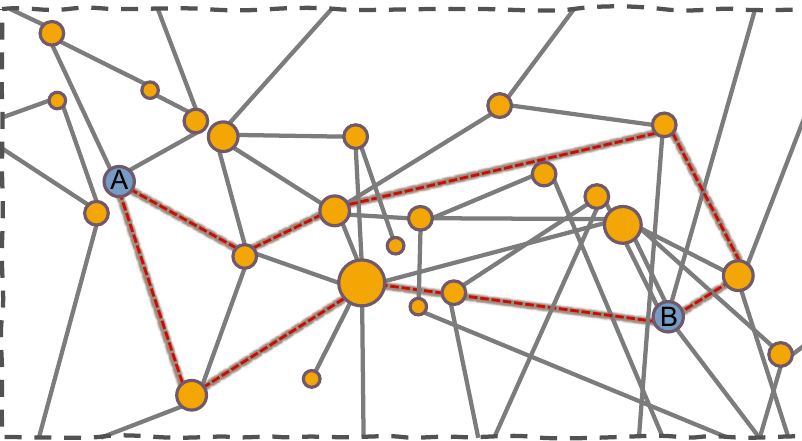
Fig. 1 Quantum communication network. Two arbitrary end-users, Alice (A) and Bob (B), can communicate through diverse, not necessarily direct, routes that extend across intermediate untrusted sender-receiver pairs that act as relays (yellow nodes). Two possible routes are highlighted in red. The quantum network is Gaussian if the operations at the nodes and the channels associated with links are all Gaussian, so that the fi nal state shared by Alice and Bob is Gaussian. More weakly, we also include the possibility of non-Gaussian post-selection operations which however project into a Gaussian state when they are successful (see text for more details).